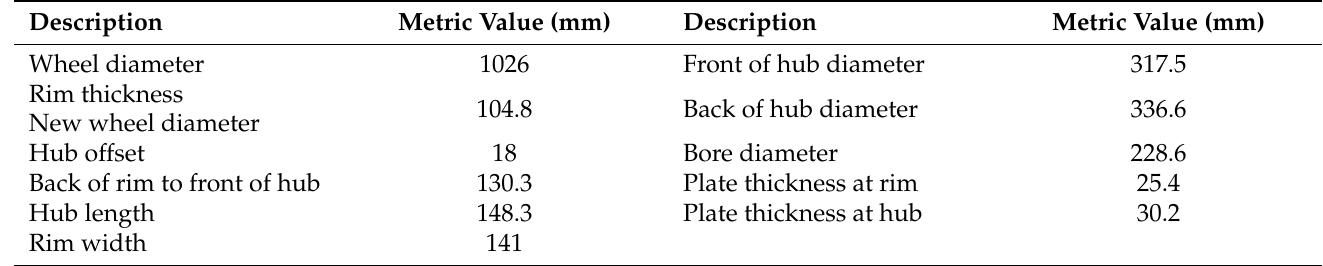
Table 6. Wheel design